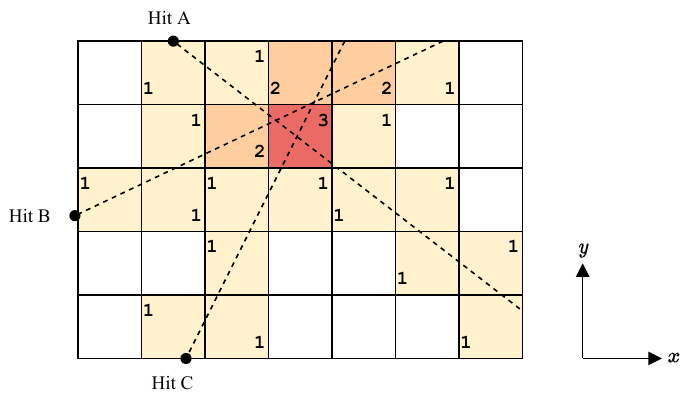
Figure 10. A 2D visualization of the particle back-tracing process and the score assignment. A hit is shown as a solid dot and its projected trajectory with a dashed line. The total, non-zero voxel scores s tot are shown in the corners of each voxel and are also represented by the